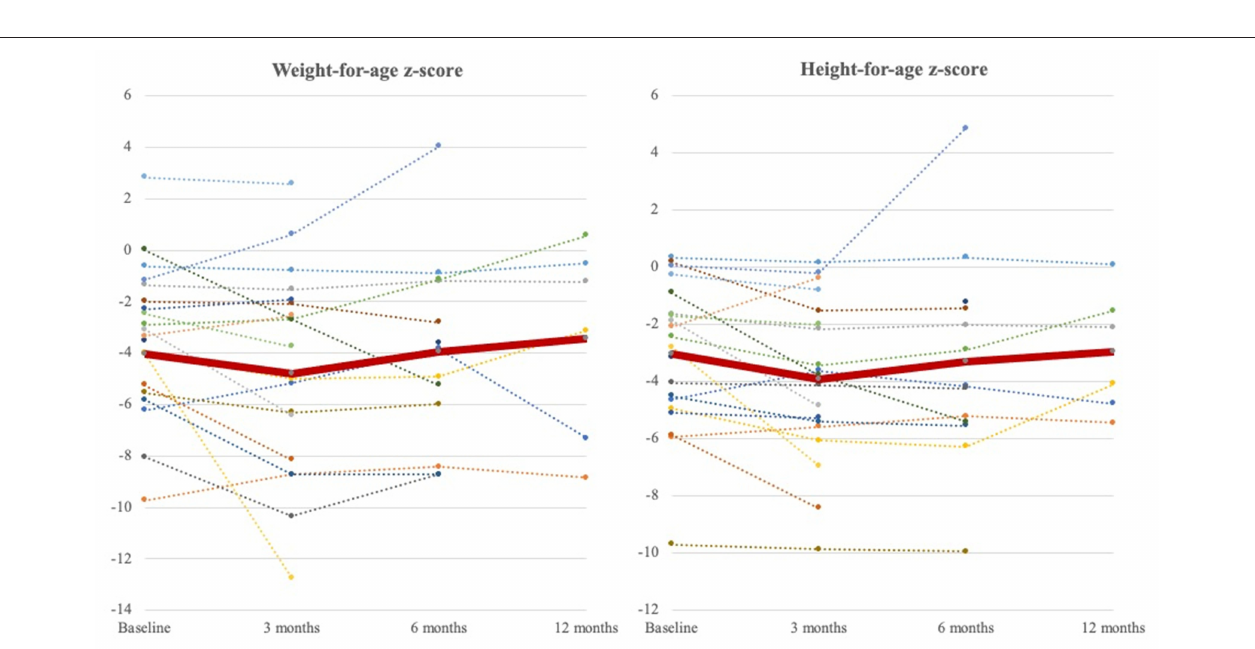
FIGURE 3 | Weight-for-age z -score and height-for-age z -score curve at 3 months, 6 months, and 1 year during follow-ups. The dot lines represent weight-for-age z -score and height-for-age z -score of individuals (baseline: N = 20, 3 months; N = 20, 6 months; N = 13, 1 year: N = 6). The thick red line represents the average of all patients. The nadir occurred at 3 months after NE tube placement and increased to exceed baseline until a 1-year follow-up.